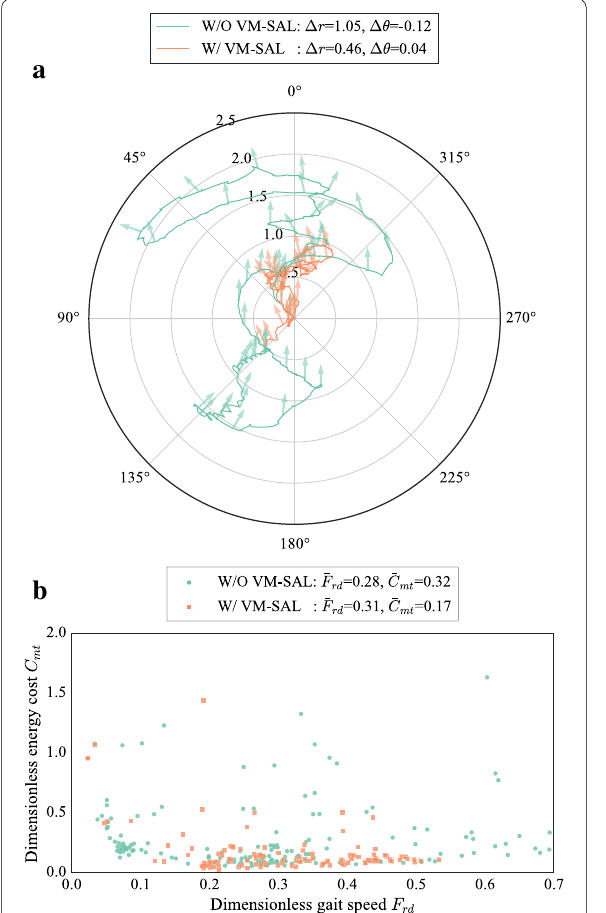
Fig. 12 Evaluation of secureness and efficiency both indexes are improved about twice by VM-SAL. a Distance between the robot and the leader point. b Specific resistance in related to the gait speed